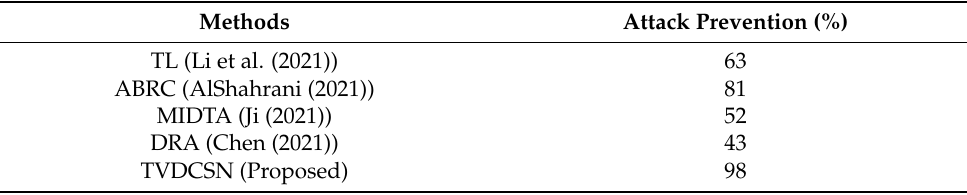
Table 2. Values of proposed and existing methods of attack prevention.